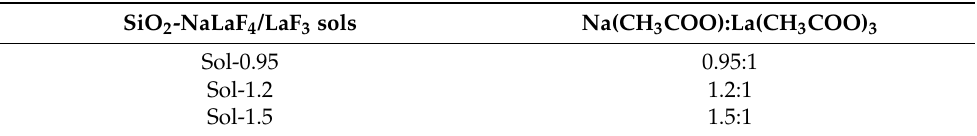
Table 1. Identification of SiO 2 -NaLaF 4 /LaF 3 sols depending on the molar ratio of Na/La precur- sors used. SiO 2 -NaLaF 4 /LaF 3 sols Sol-0.95 Sol-1.5